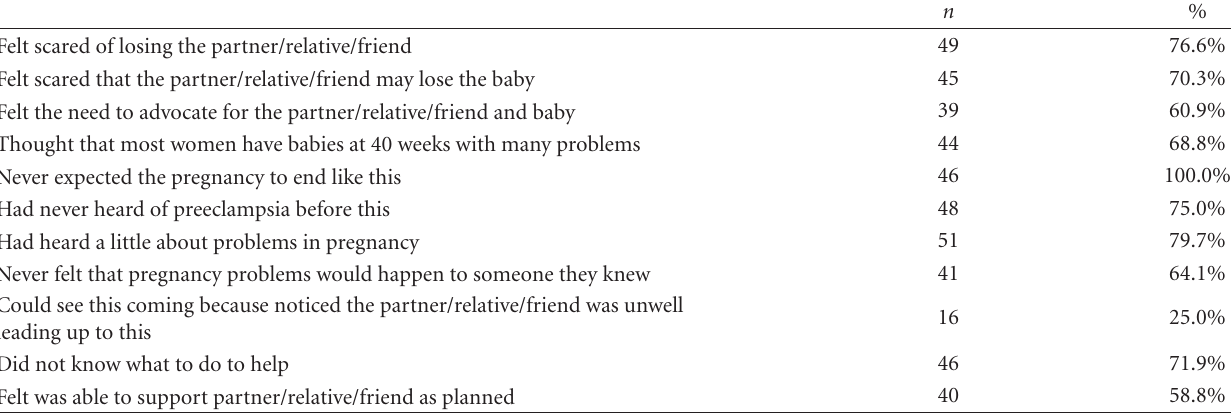
Table 3: The PE experience from the perspective of the women’s partners, family member, or close friends.